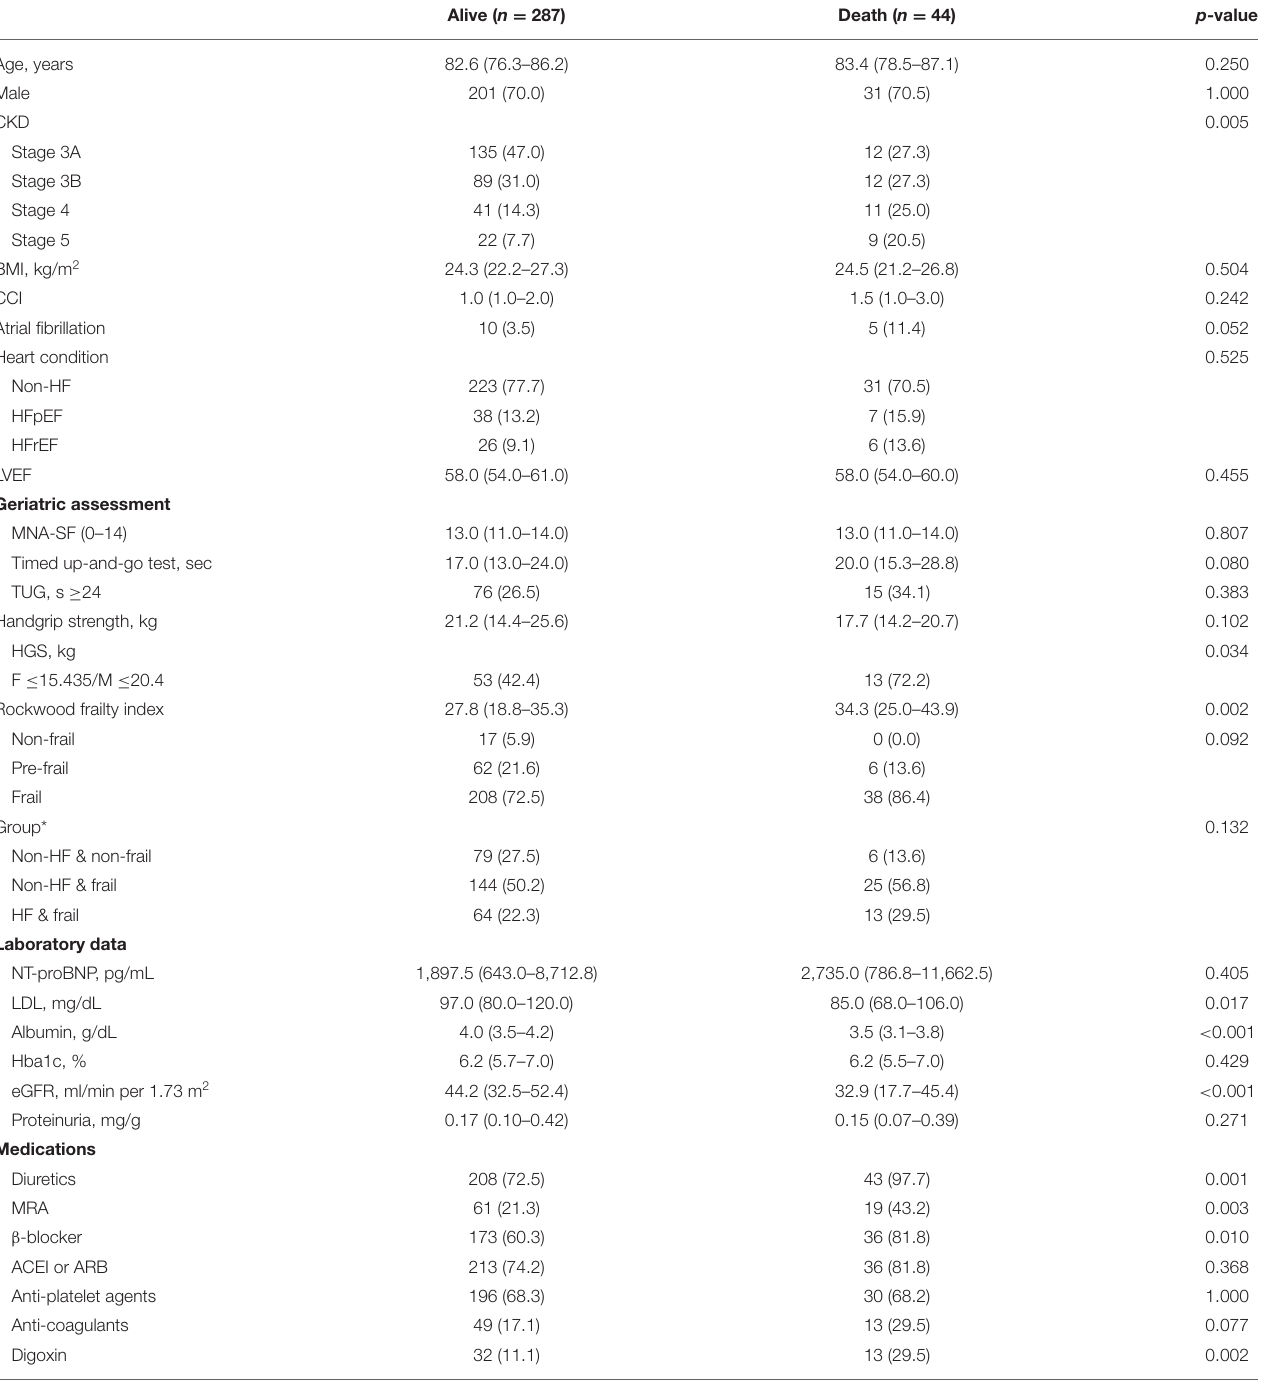
TABLE 4 | Comparison between survivors and non-survivors in older patients with CKD.